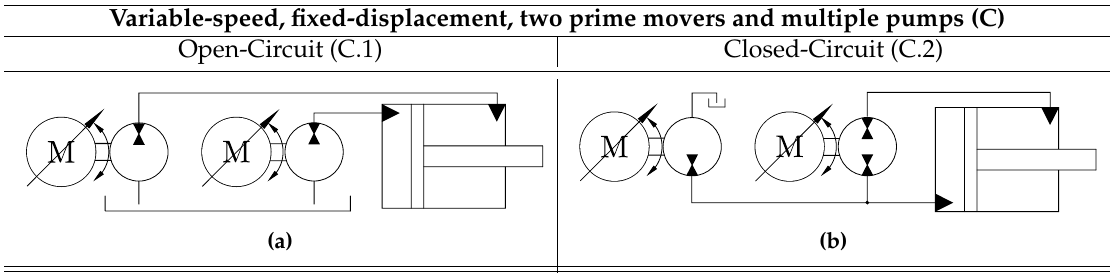
Figure 7. Overview of class C architectures (simplified schematics). ( a ) Open-circuit configuration; ( b ) Closed-circuit